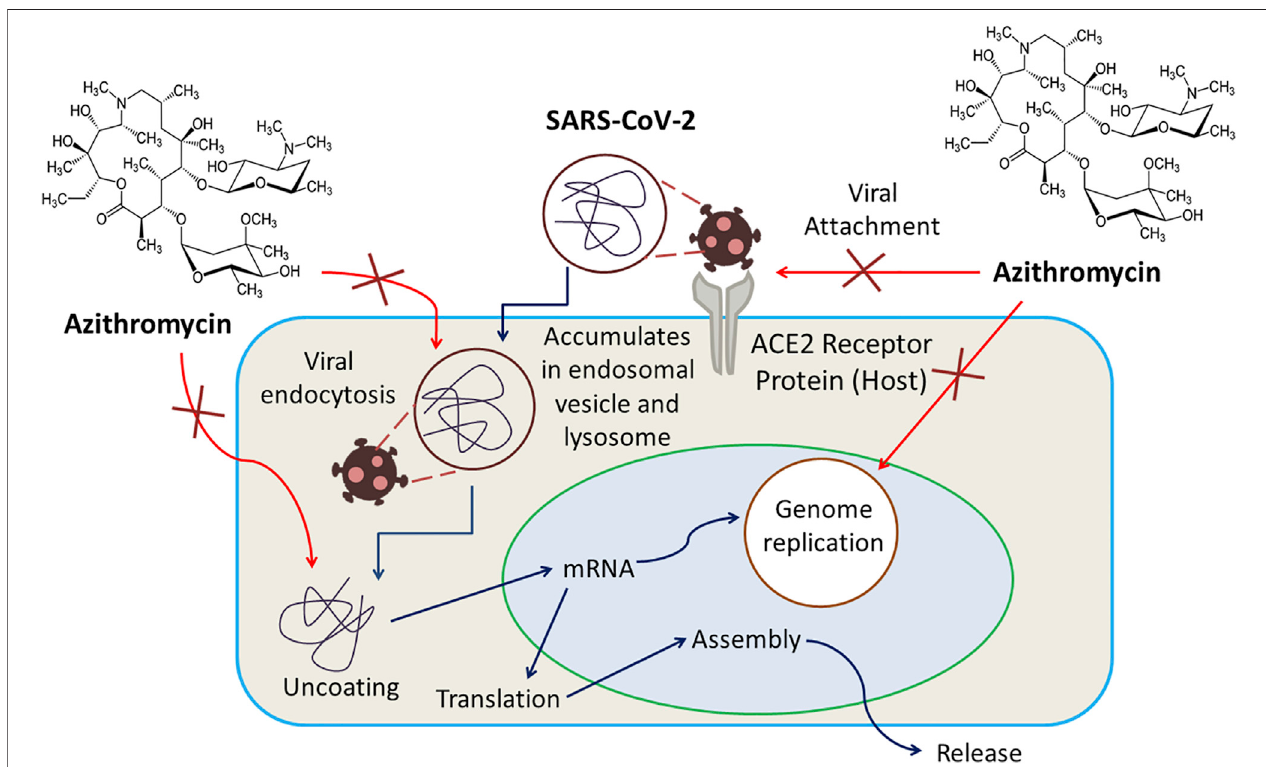
FIGURE3 | Azithromycinexertsinhibition of uncoating ofcoronaviruses, ampli fi cation of host ’ s interferon (IFN) pathway-mediated antiviralresponsesresultingin a reduction of viral replication, interference in the binding interaction of SARS-CoV-2 spike protein and host receptor ACE2 protein as well as viral endocytosis.